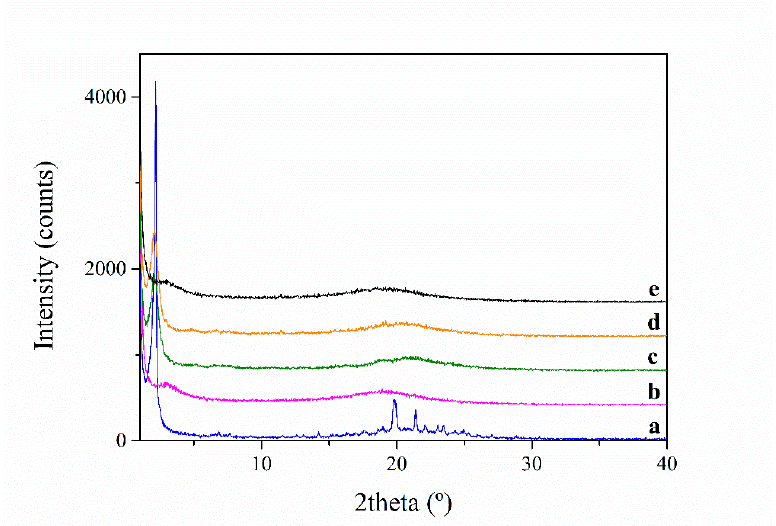
Figure 5. XRD pattern of PAZE100: ( a ) native at 296 K; ( b ) after heating 10 K/min to 353 K; ( c ) after cooling 1 K/min to 272 K; ( d ) after 2 h annealing at 318 K; ( e ) after subsequent heating to 353 K.